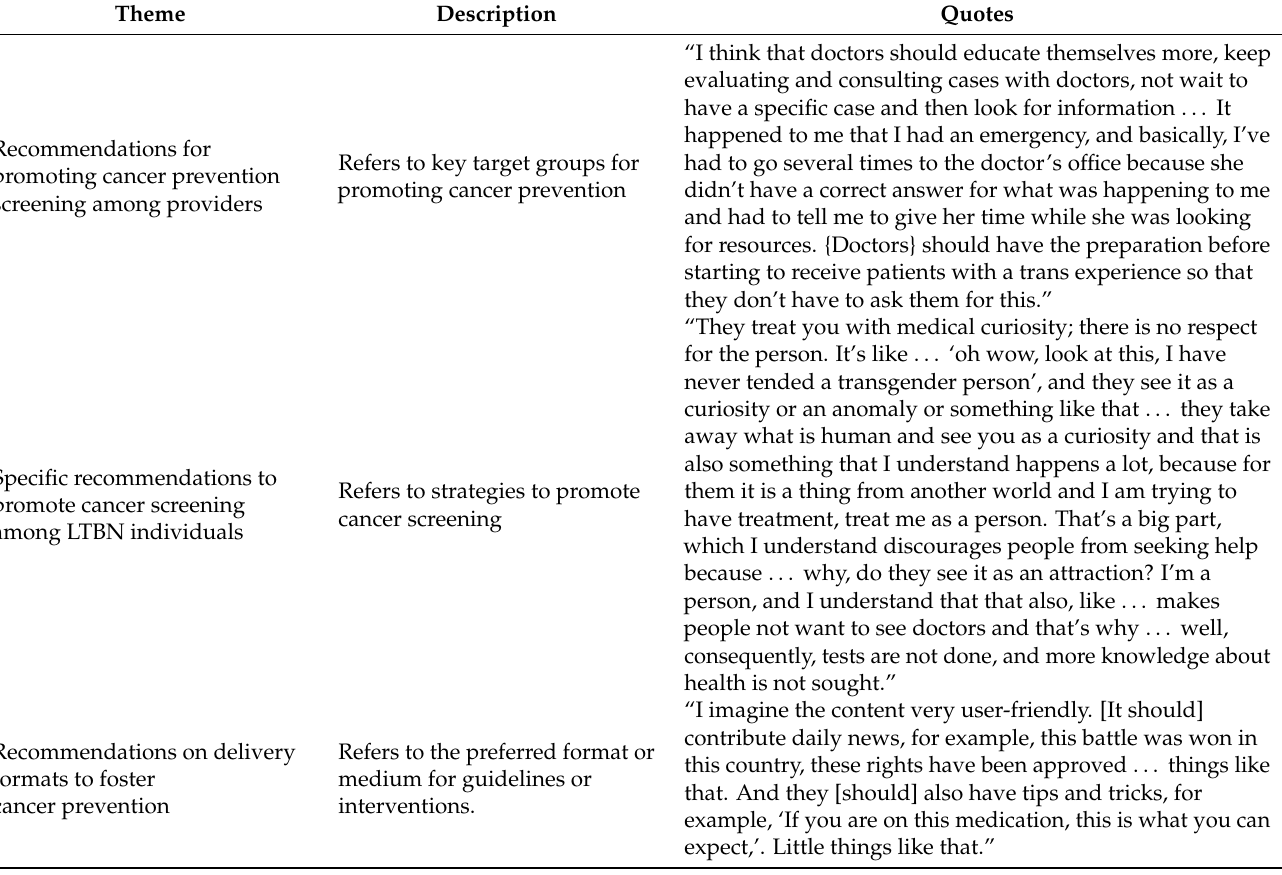
Table 4. Themes of